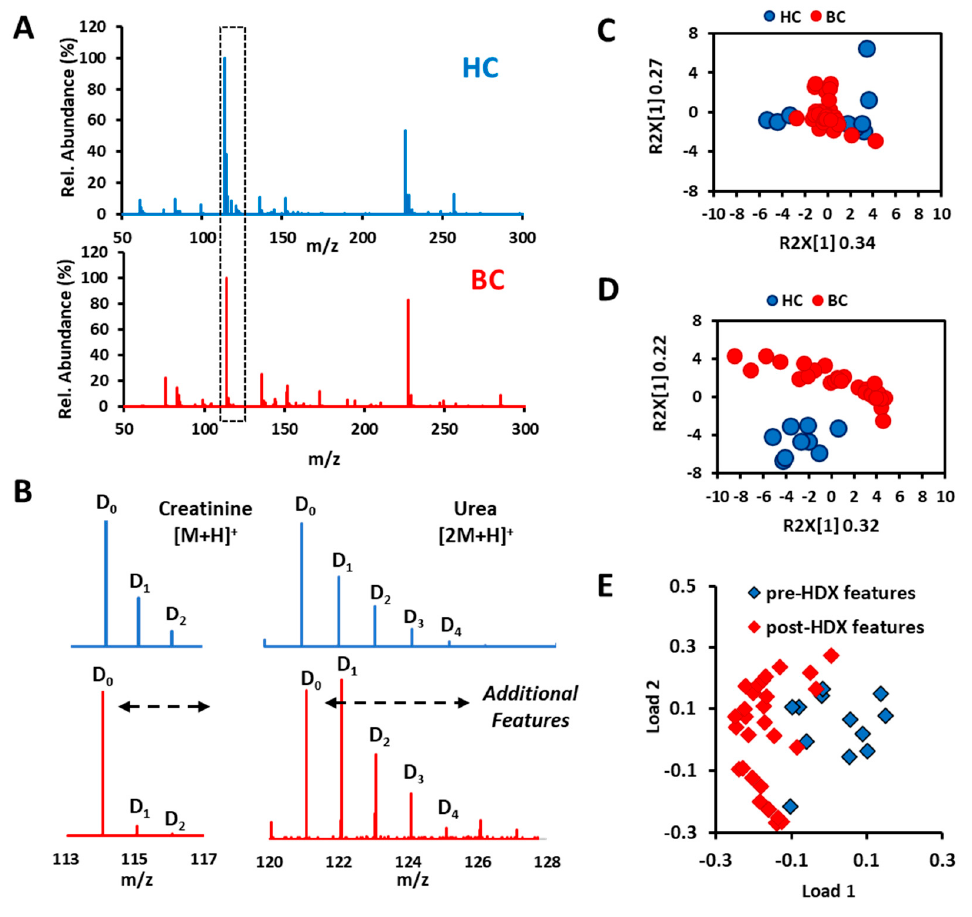
Figure 6. HDX for statistics-free highlight of the cancer signature. ( A ) Average mass spectra with HDX acquired from bladder cancer and normal contrast urine samples. ( B ) Typical metabolite ions that have a significant difference between two groups can be directly observed. ( C ) PCA score plots based on the original features collected from the plain metabolic profile. ( D ) PCA score plots based on the original features and newly generated deuterium peaks as the additional features. ( E ) PCA loading plot that visualizes the weight coefficient of each feature to the clustering. The dashed region in ( A ) is enlarged to form what is shown in ( B ).